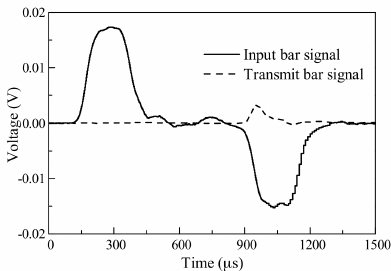
Figure 4. Typical wave